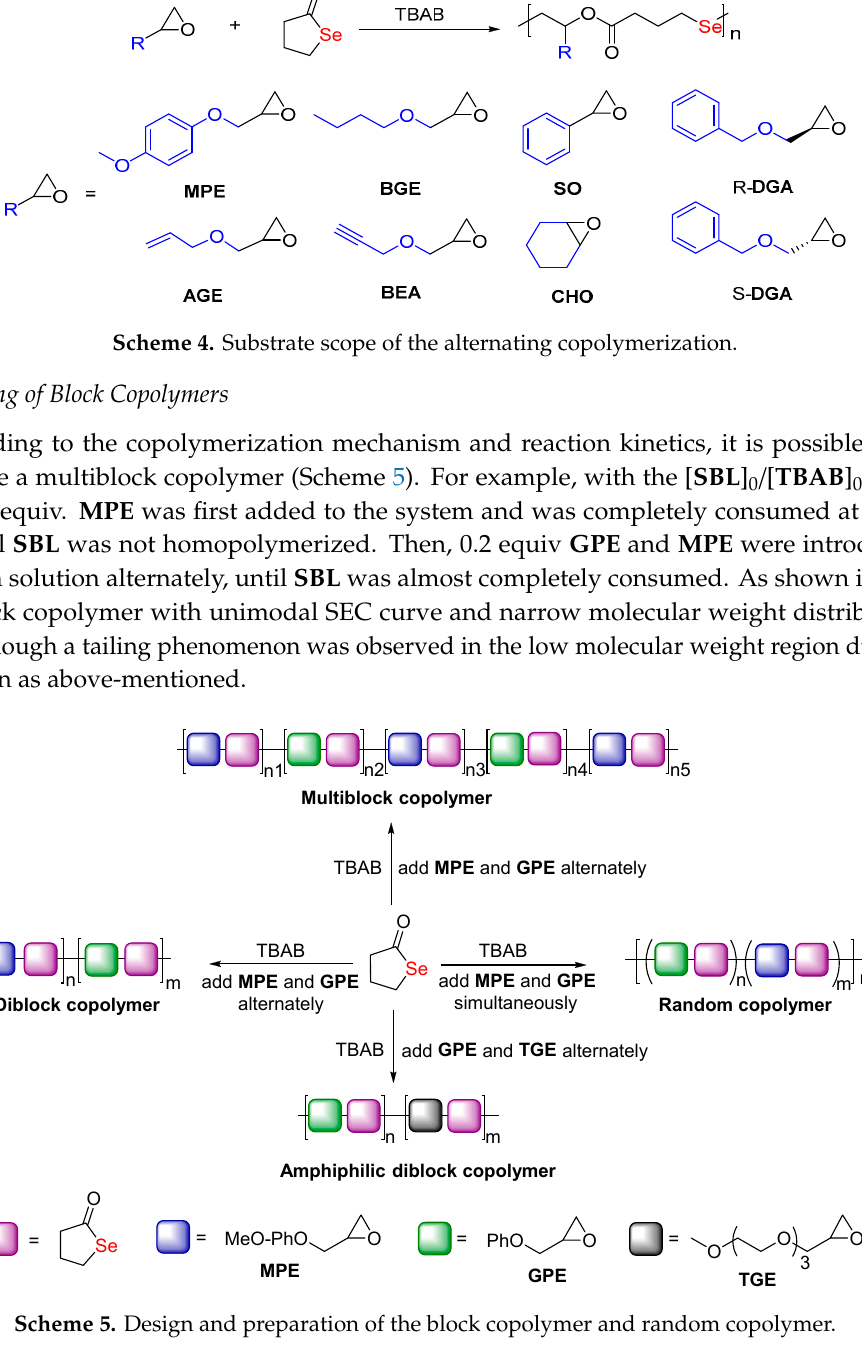
Table 2. Copolymerization of various oxiranes with SBL a